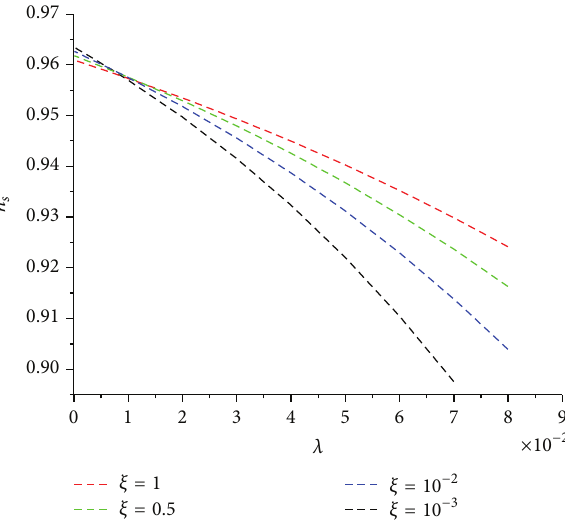
Figure 2: 𝑟 versus 𝑇 for different values of 𝜆 for 𝜉 𝑐 = 3/16 and 𝑁 = 60 .